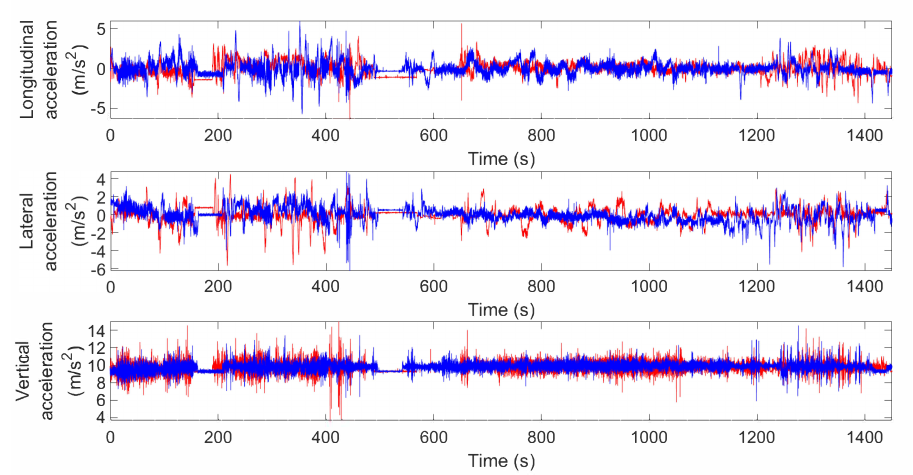
Figure 5. Longitudinal, lateral and vertical acceleration for the same driver driving both cars: Crossover (red) and Sedan